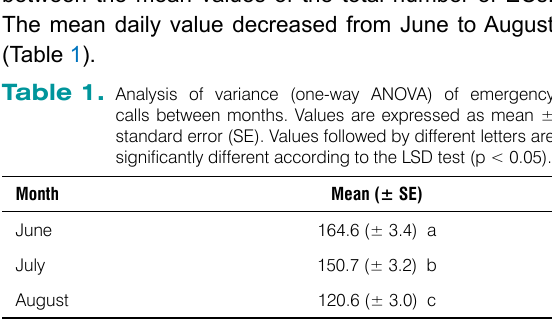
Figure 2. Hourly distribution of Emergency Calls during summer 2005 in Florence.